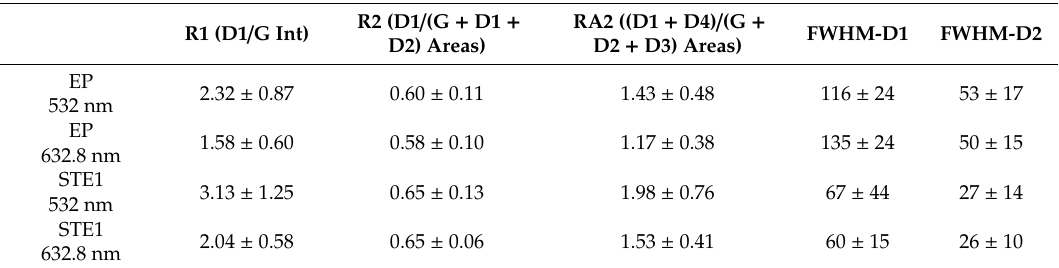
Table 4. Mean values and standard deviations of the parameters used for temperature estimations by the five equations employed in this